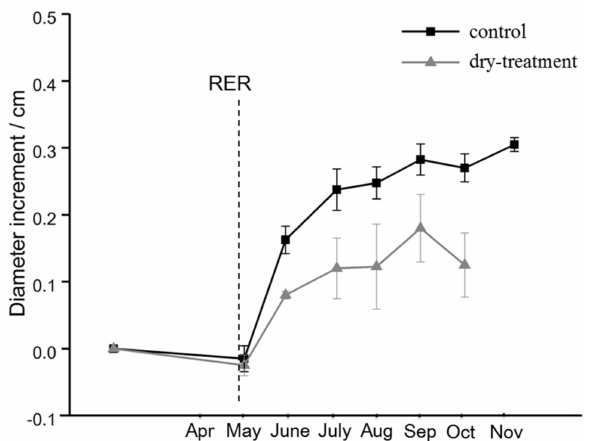
Figure 3. Stem diameter growth of the control and dry-treatment groups of T. cordata Greenspire measured at a height of 1 m from April to November 2017. The panel represents the mean value, and error bars indicate standard deviation. Due to an unexpected failure of the digital caliper, the data for the treatment group in November was missing.